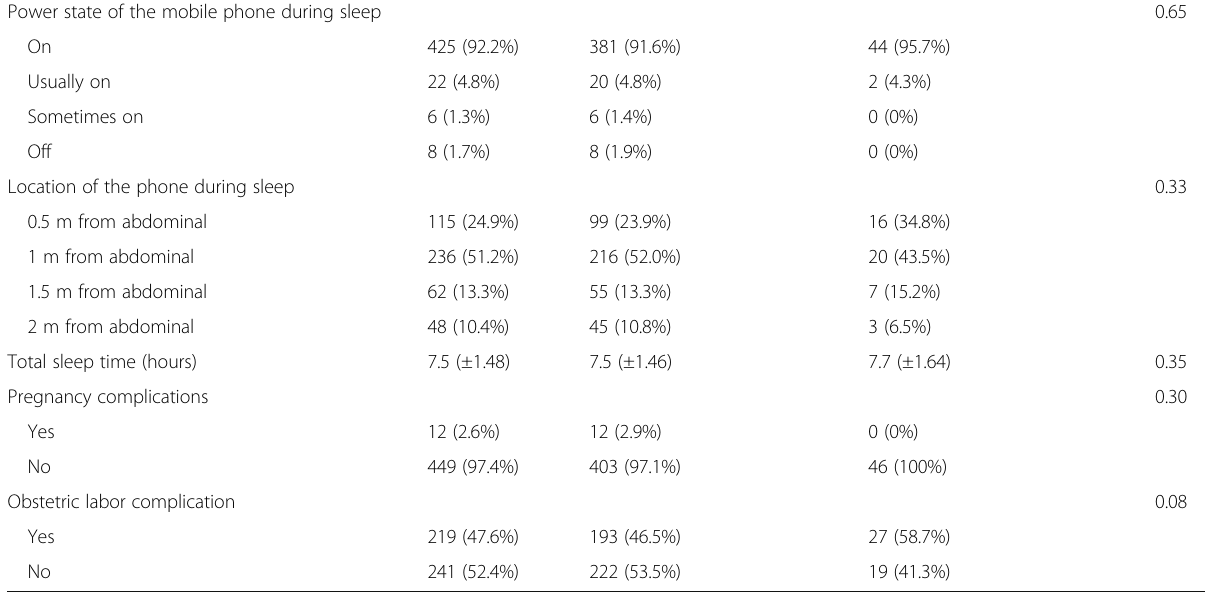
Table 1 Maternal characteristics and their differences between the normal and excessive use groups (Continued) Power state of the mobile phone during sleep